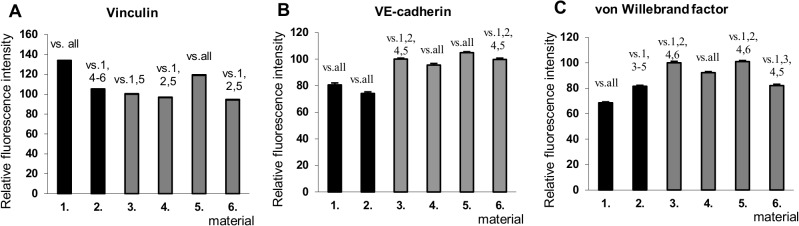
Intensity of immunofluorescence staining for vinculin (on day 3, A), VE-cadherin (on day 7, B) and von Willebrand factor (on day 7, C) of CPAE cells cultured on different surfaces.(1) tissue culture polystyrene (TCPS); (2) TCPS with 10 ng/mL of FGF-2sol in media (TCPS_FGF-2sol); (3) (Alb/Hep)2; (4) (Alb/Hep)2 with 10 ng/mL of FGF-2sol in media ((Alb/Hep)2FGF-2sol); (5) (Alb/Hep)2 with adsorbed FGF-2ads (30 ng/cm2, (Alb/Hep)2FGF-2adsLow); (6) (Alb/Hep)2 with adsorbed FGF-2ads (120 ng/cm2, (Alb/Hep)2FGF-2adsHigh). Cells were cultured in 5% FBS media. Fluorescence intensity is normalized per cell. The data is expressed as mean ± S.E.M. Statistically significant differences (p value <0.05) between surfaces (denoted in numbers) are depicted above bars.